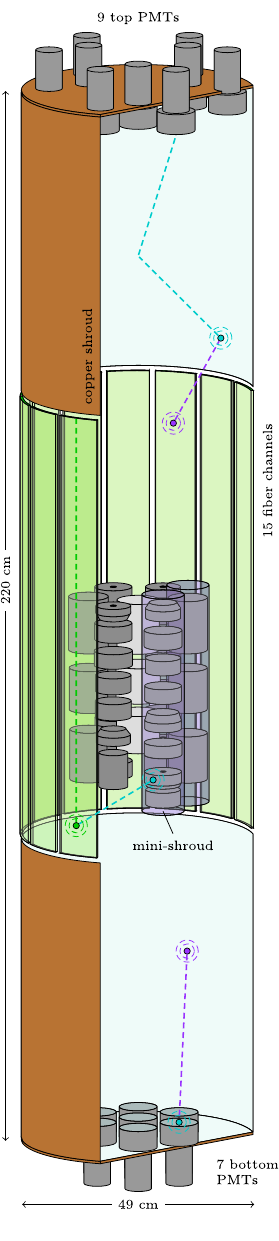
Fig. 1 LAr veto instrumentation concept. Transport of light signals towards the PMTs or SiPMs relies on WLS processes in the TPB layers or optical fibers. Several potential light paths are indicated. Support structure details, electronics as well as individual fibers are not drawn